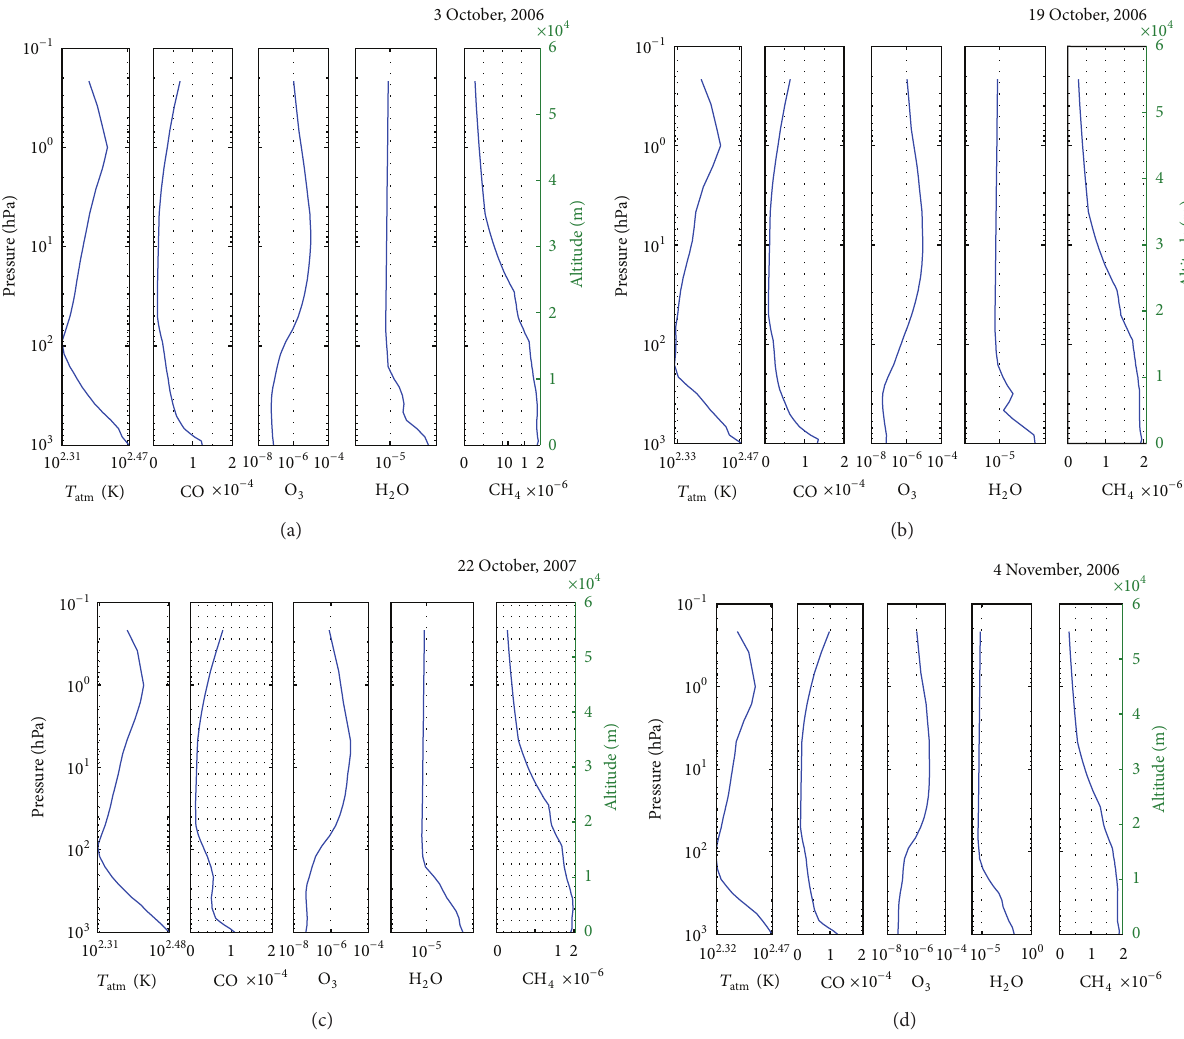
Figure 2: Vertical profiles of TES-derived parameters for selected dates experiencing the black cloud pollution episode during 2006 and